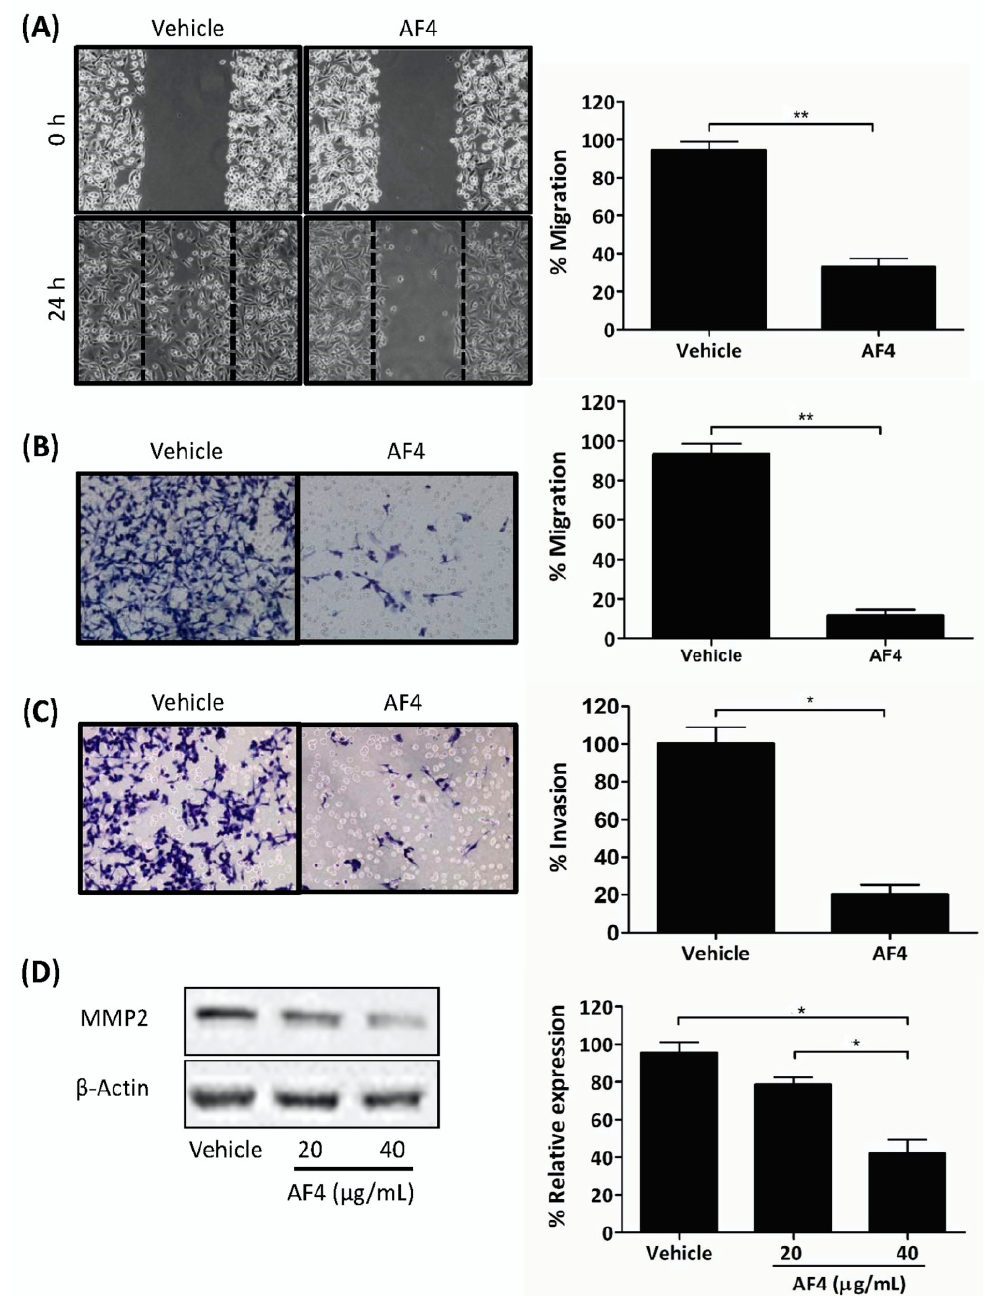
Figure 3. AF4 inhibits breast cancer cell motility and invasion. ( A ) Mitomycin C-treated MDA-MB-231 cells were cultured in wells containing cell culture inserts, which were removed at 0 h. After 24 h culture in the absence or presence of 20 µg/mL AF4 cultures were photographed. Representative images and mean % migration ± SEM of 3 independent experiments are shown. ( B ) Serum-starved MDA-MB-231 cells were treated with 20 µg/mL AF4 for 24 h. Mean % migration ± SEM through an 8 µm porous membrane and ( C ) mean % invasion ± SEM through a fibronectin-coated 8 µm porous membrane were determined as described in the Methods. ( D ) MDA-MB-231 cells were cultured for 24 h in the absence or presence of the indicated concentrations of AF4. Relative expression of MMP2 was determined using Western blot analysis. Equal protein loading was confirmed by probing for β -actin expression. Data shown are representative blots and mean % relative expression ± SEM. Statistical analysis of 3 independent experiments was performed using (A–C) Student’s t -test or (D) ANOVA and Tukey’s multiple comparisons test; * p < 0.01, ** p <